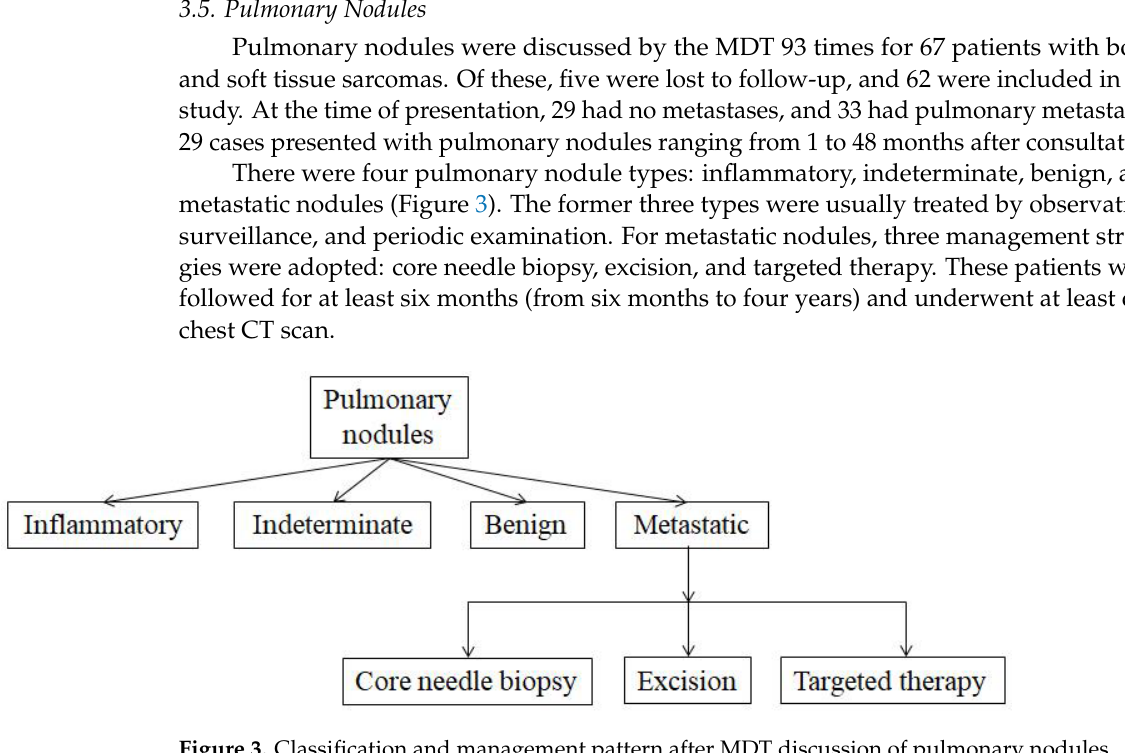
Table 5. Management and outcome of non-metastatic pulmonary nodules.